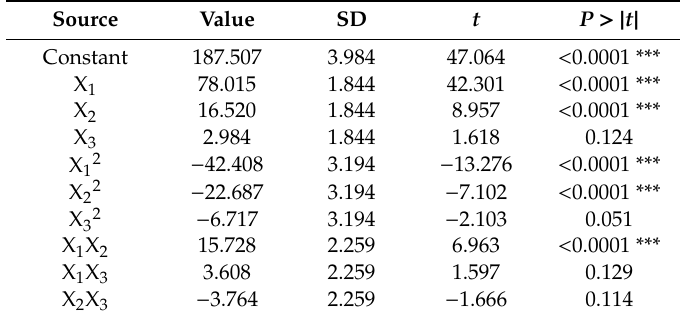
Table 4. Statistical analysis of the regression coe ffi cients of UAE of TFC from N. lotus stamens.